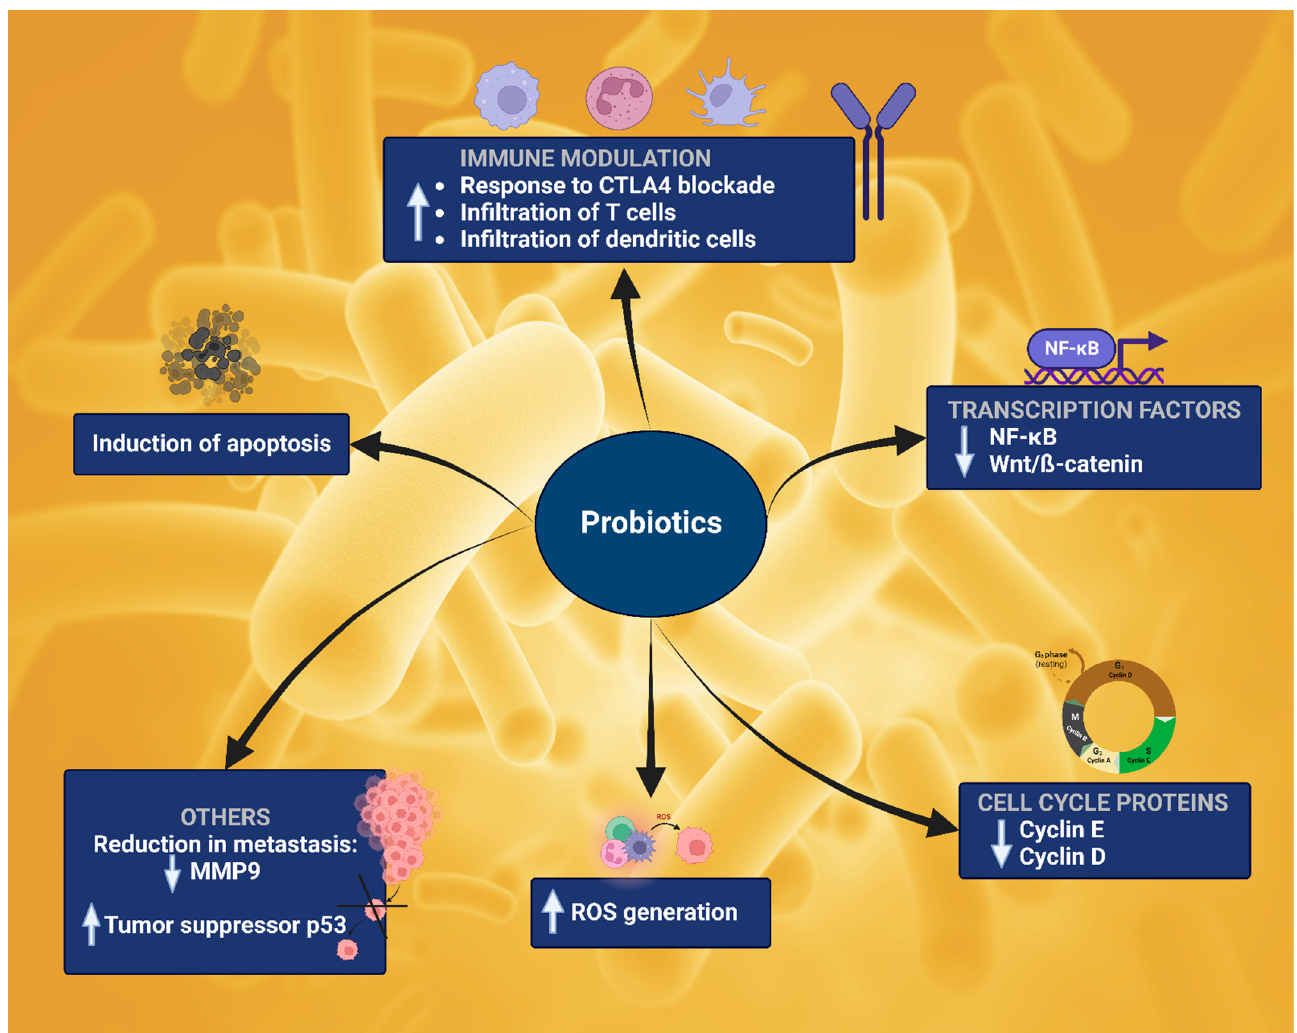
Figure 3. General scheme of molecular mechanisms by which probiotics exert anticancer effects. (Figure created with Biorender.com). Table 2. Mechanisms of different probiotics used to treat cancer.